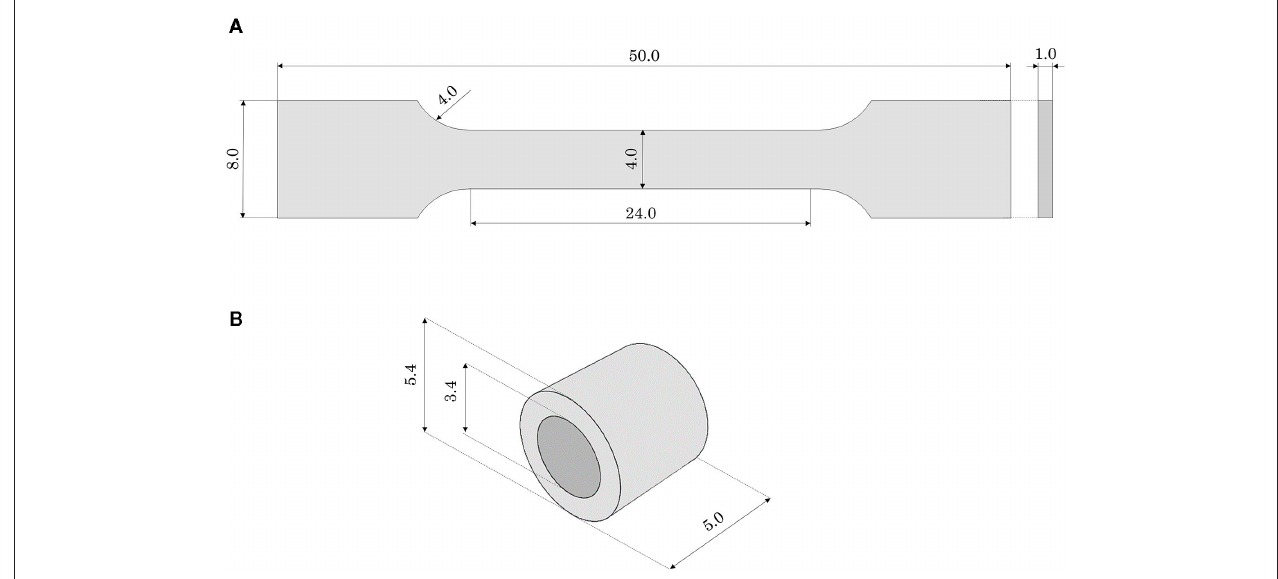
FIGURE 2 | Geometrical features (in mm) of (A) the dog-bone and (B) the ring samples made of